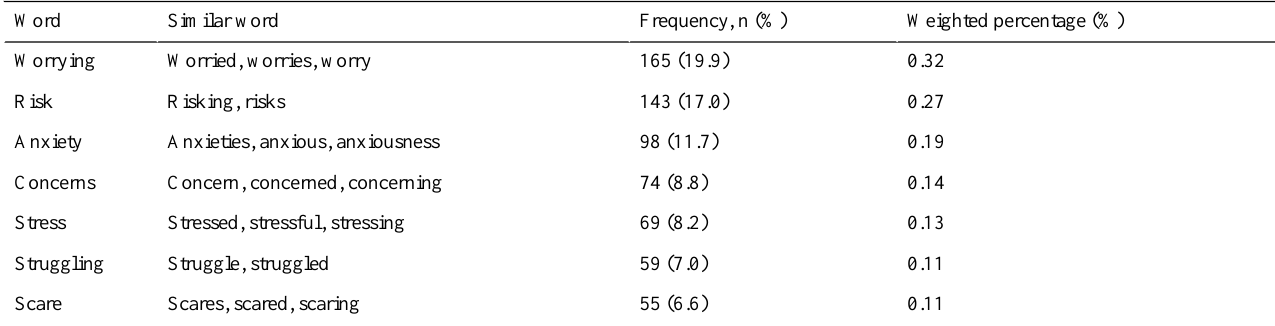
Table 1. Word frequency in total posts (N=831).